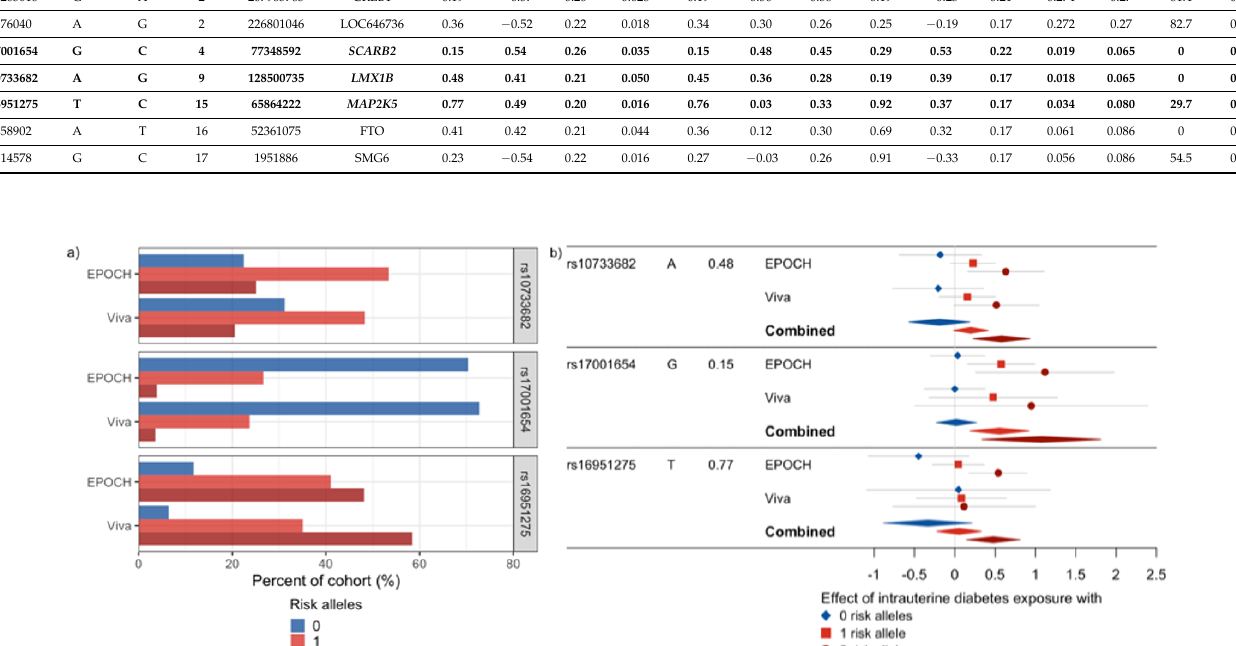
Table 2. Information on the SNPs showing significant interactions with in utero diabetes exposure in regression models of BMI z-scores in the EPOCH cohort. This table shows the regression results for the interaction terms between the SNPs and intrauterine diabetes exposure statuses from the regression models of the BMI z-score in EPOCH and Project Viva (controlling for birthweight and the first three genetic principal components), as well as the meta-analyzed results for the interaction terms with nominally significant variants shown in bold. The consistency of the observed interaction effect sizes across the two studies was assessed using the I² statistic, which describes the percentage of variation across studies that is due to heterogeneity rather than chance. EPOCH Interaction Interaction Interaction Heterogeneity Effect Fre- Beta SE p SE SNP Other Allele Chr. Position (bp) Nearest Gene quency